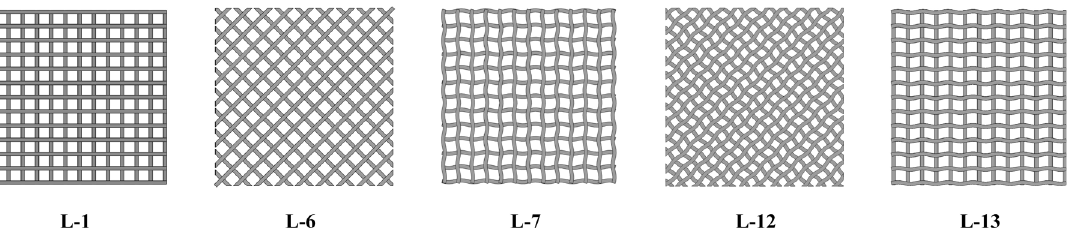
Figure 10. Plane diagrams of specimens with different strut styles and arrangement forms.